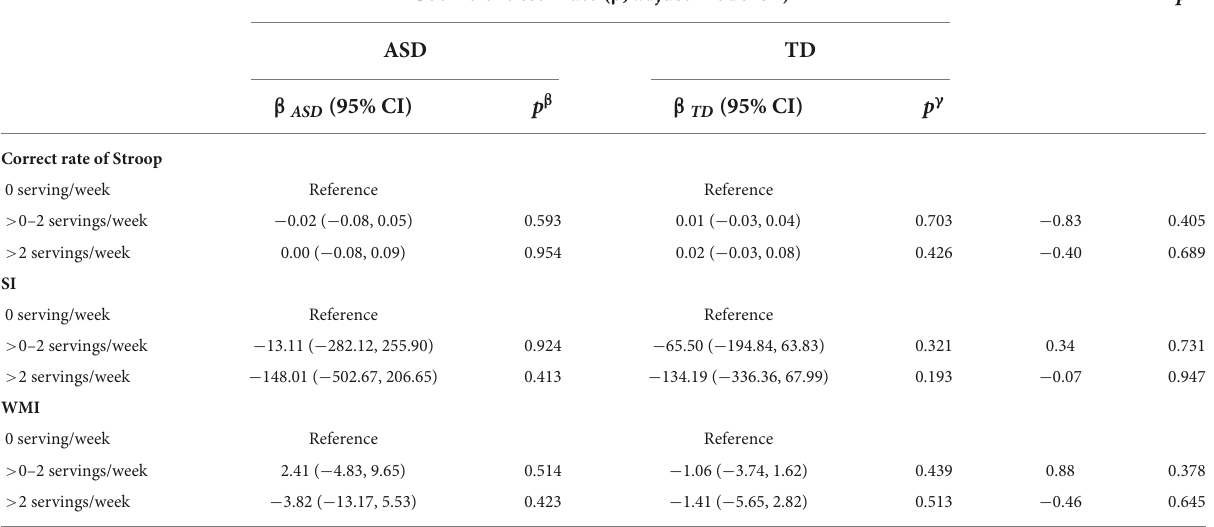
TABLE 3 Association between SSB consumption and behavioral experiments among the two groups, and the comparison between the β of the two groups. Coefficient estimate ( β , adjust model 3 α ) Z δ p